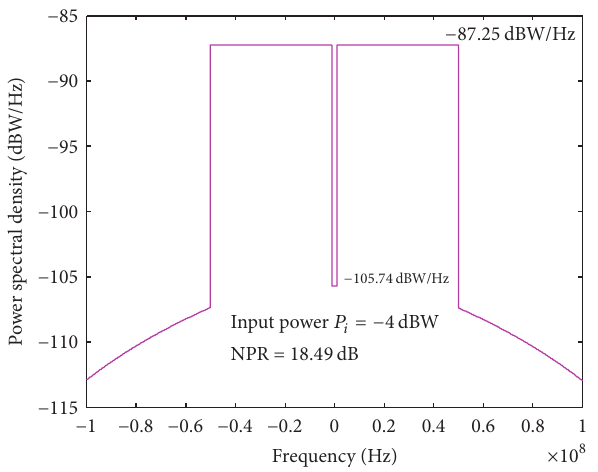
Figure 9: Amplifier output noise power spectral density with 𝑃 𝑖 = −4 dBW, 𝐵 notch = 2 MHz, and notch depth = 80 dB.